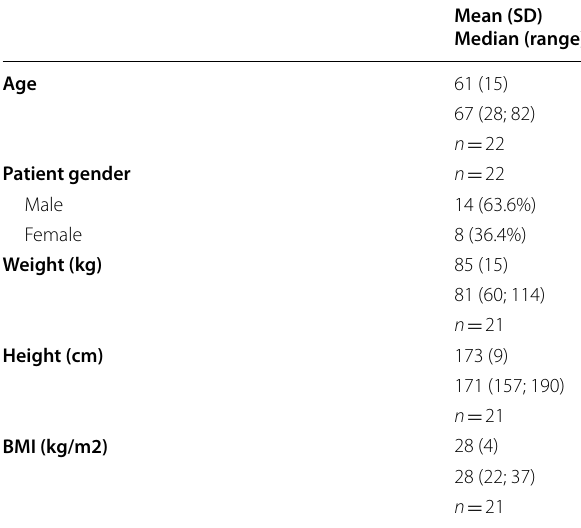
BMI Body Mass Index, CATR Chronic Achilles Tendon Rupture, N/A not available